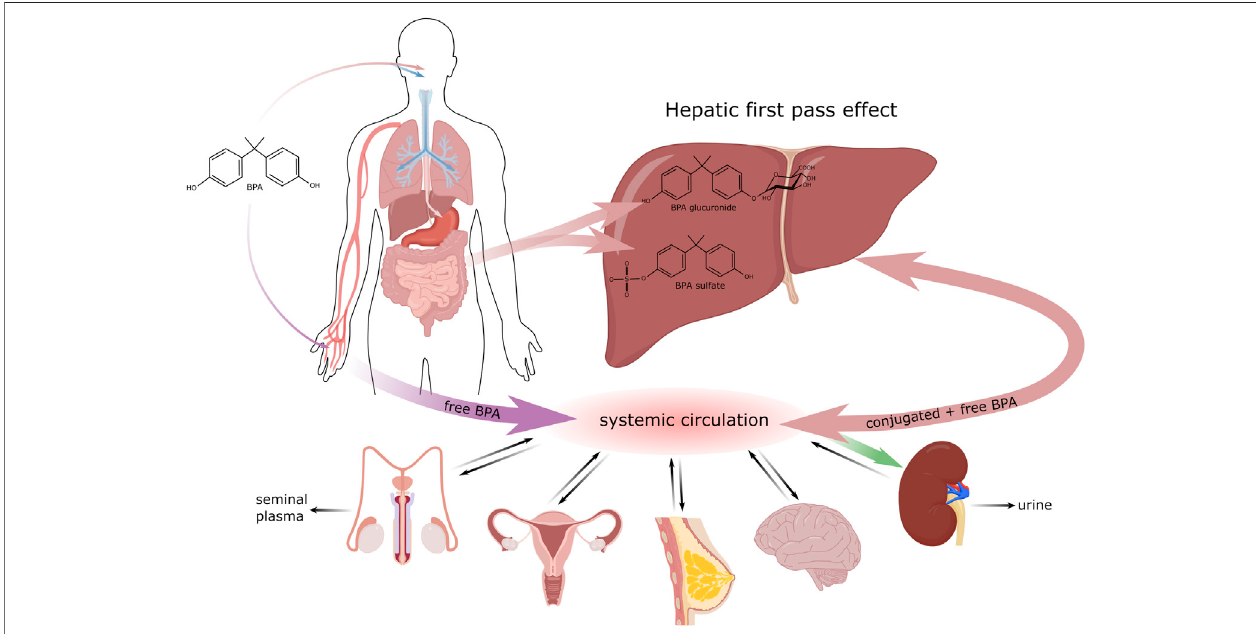
FIGURE 1 | Biotransformation of BPA in the